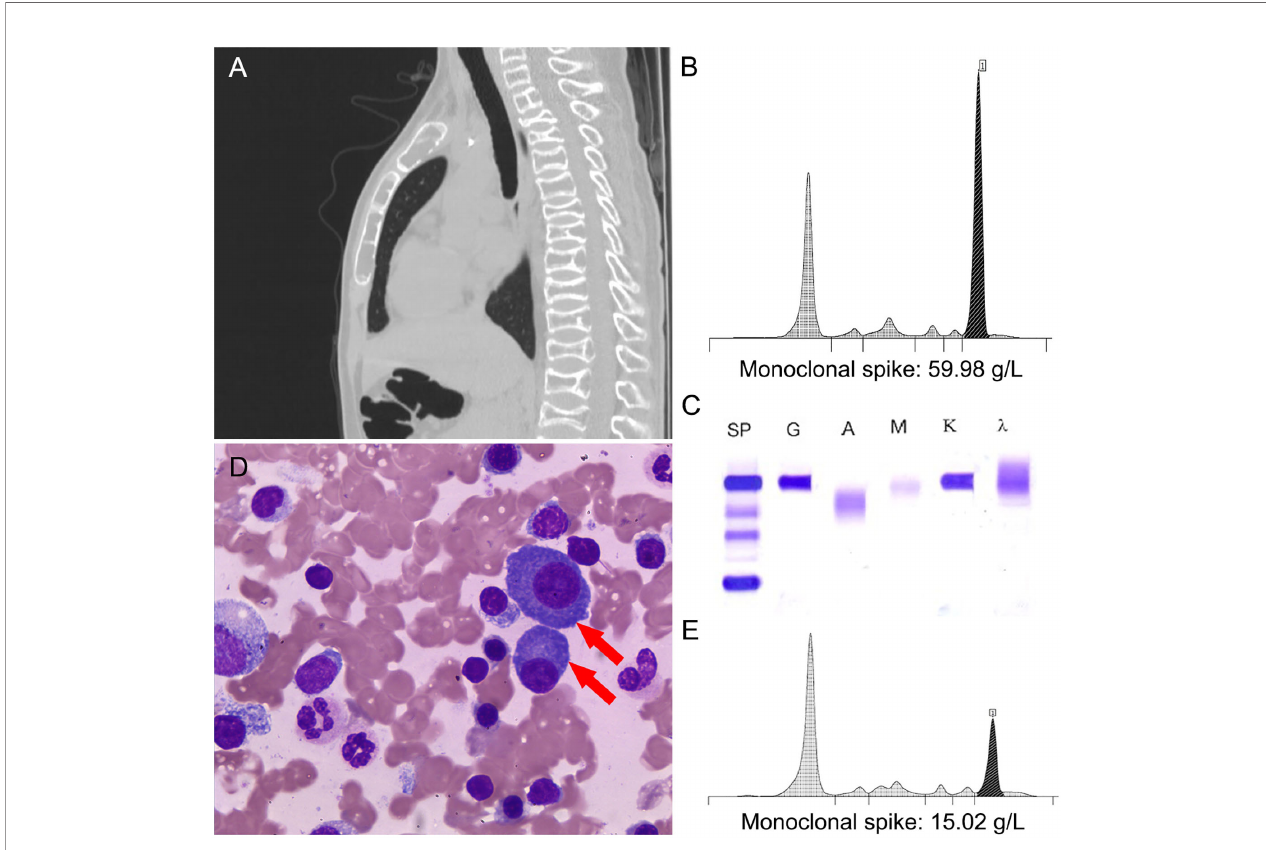
FIGURE 1 | (A) Chest computed tomography (CT) scan. (B) Protein electrophoresis for gamma globulin levels (black) before treatment. (C) Serum immuno fi xation electrophoresis demonstrating monoclonal IgG kappa proteins. (D) Bone marrow cytology (red arrows: plasma cells, ×400). (E) Protein electrophoresis for gamma globulin levels (black) after autologous hematopoietic stem cell transplantation